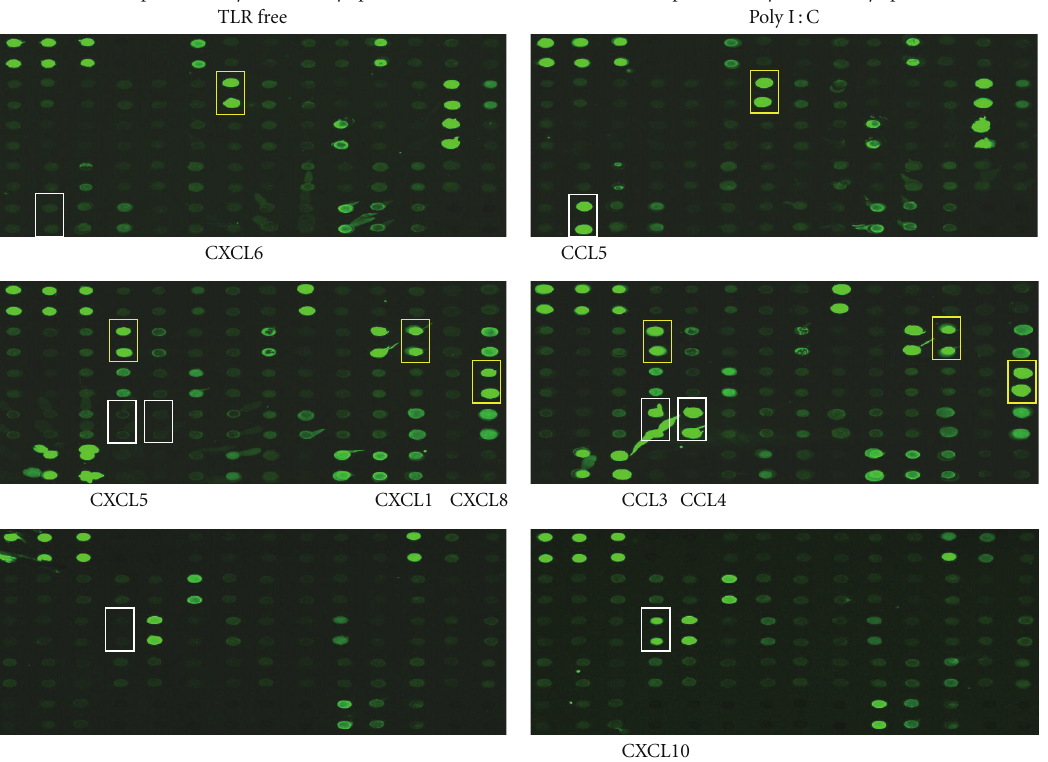
Figure 1: Chemokines produced by biliary epithelial cells under basal conditions or after stimulation with TLR3 ligand (poly I:C) for 48 hours. Cell-free culture supernatants were analyzed by a protein array kit to evaluate 174 di ff erent proteins simultaneously. Unstimulated cells produced detectable amounts of GRO- α /CXCL1, ENA-78/CXCL5, GCP-2/CXCL6, and IL-8/CXCL8, while poly I:C stimulation led to enhanced MIP-1 α /CCL3, MIP-1 β /CCL4, RANTES/CCL5, and IP-10/CXCL10.